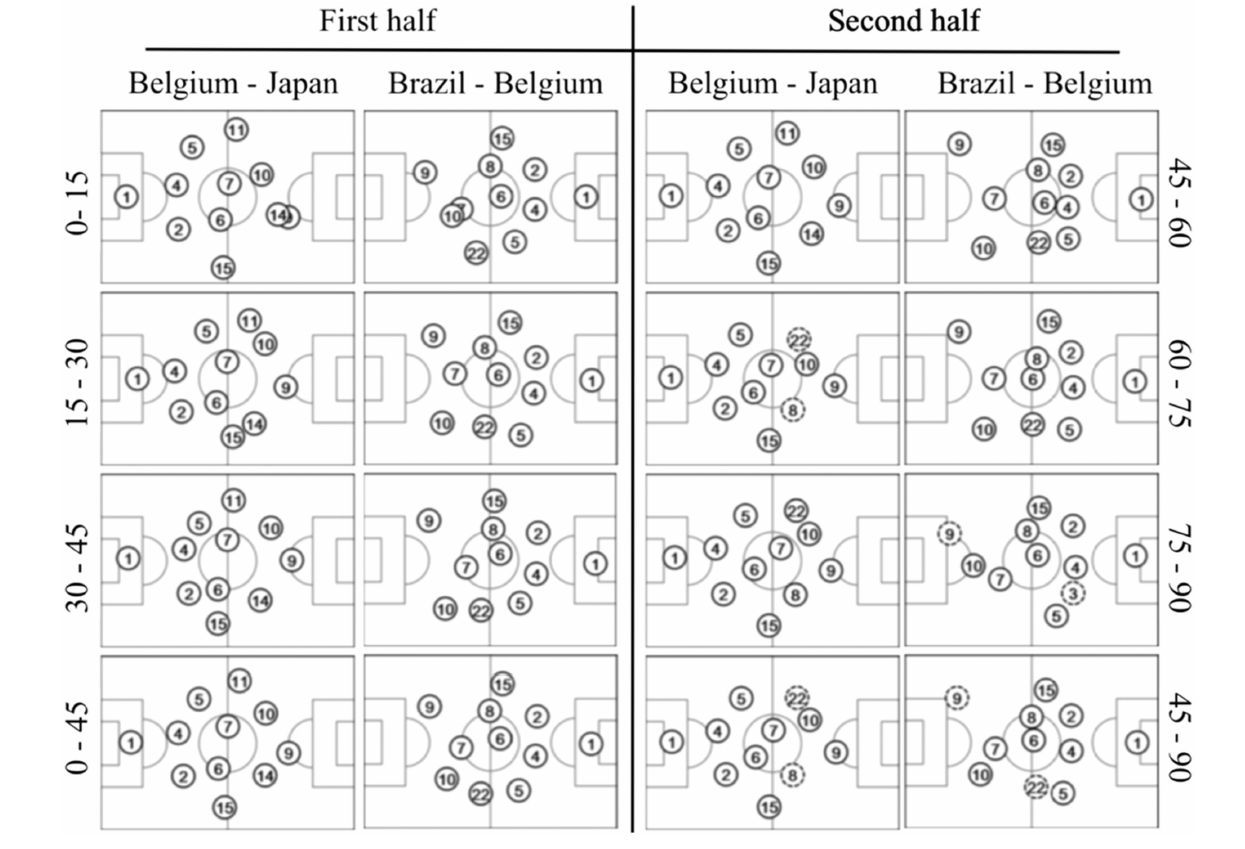
FIGURE 2 | Actual performed team formations of the Belgian national football